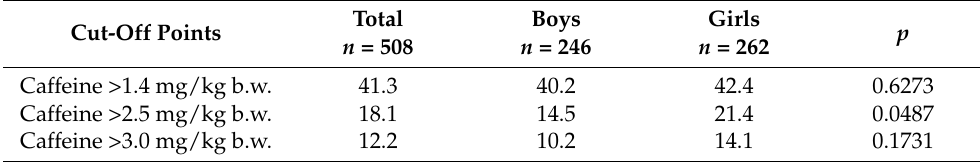
Table 4. Risk assessment of caffeine intake considering selected cut-off points [%].